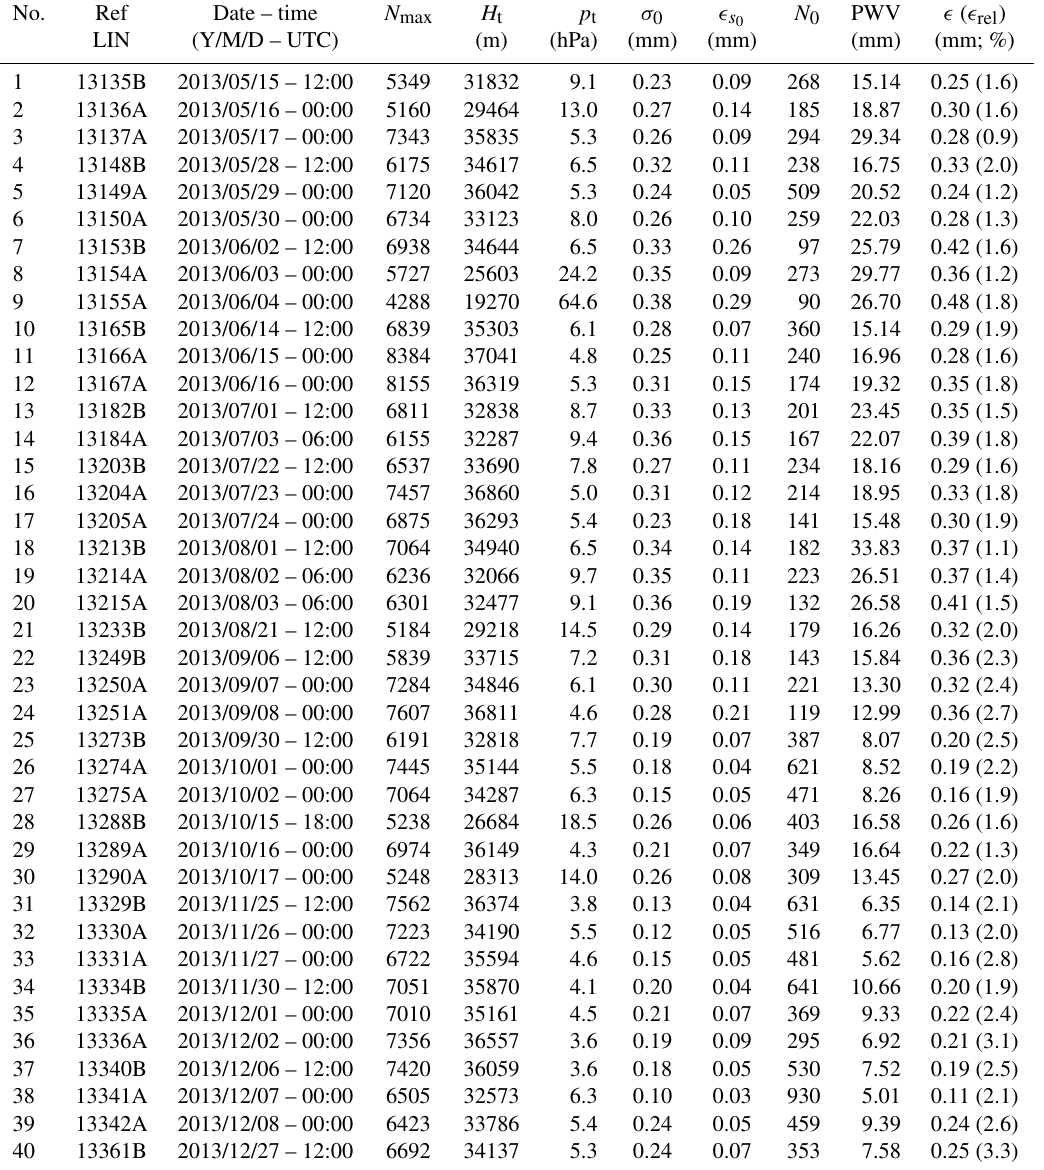
Table B3. PWV data and optimized error (cid:15) (see Eq. 19) from the radiosoundings at LIN. See the caption of Table B1 for